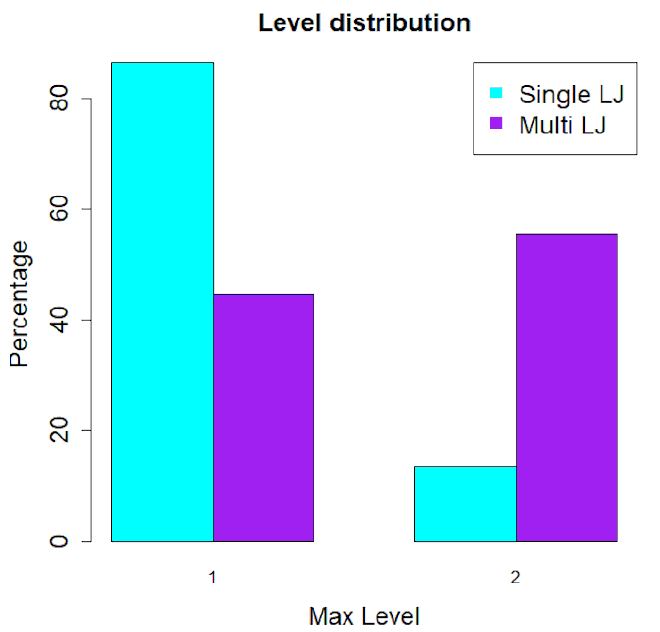
Figure 9. Maximum level distributions (in percentage) of the SLJsts (cyan) and MLJsts